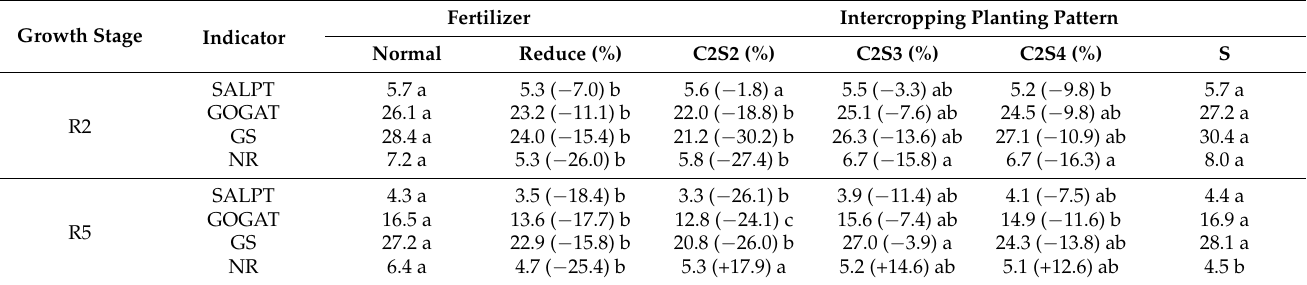
Table 4. Mean of nitrogen-metabolization-related enzymatic activity under normal and reduce fertilizer in four intercropping planting